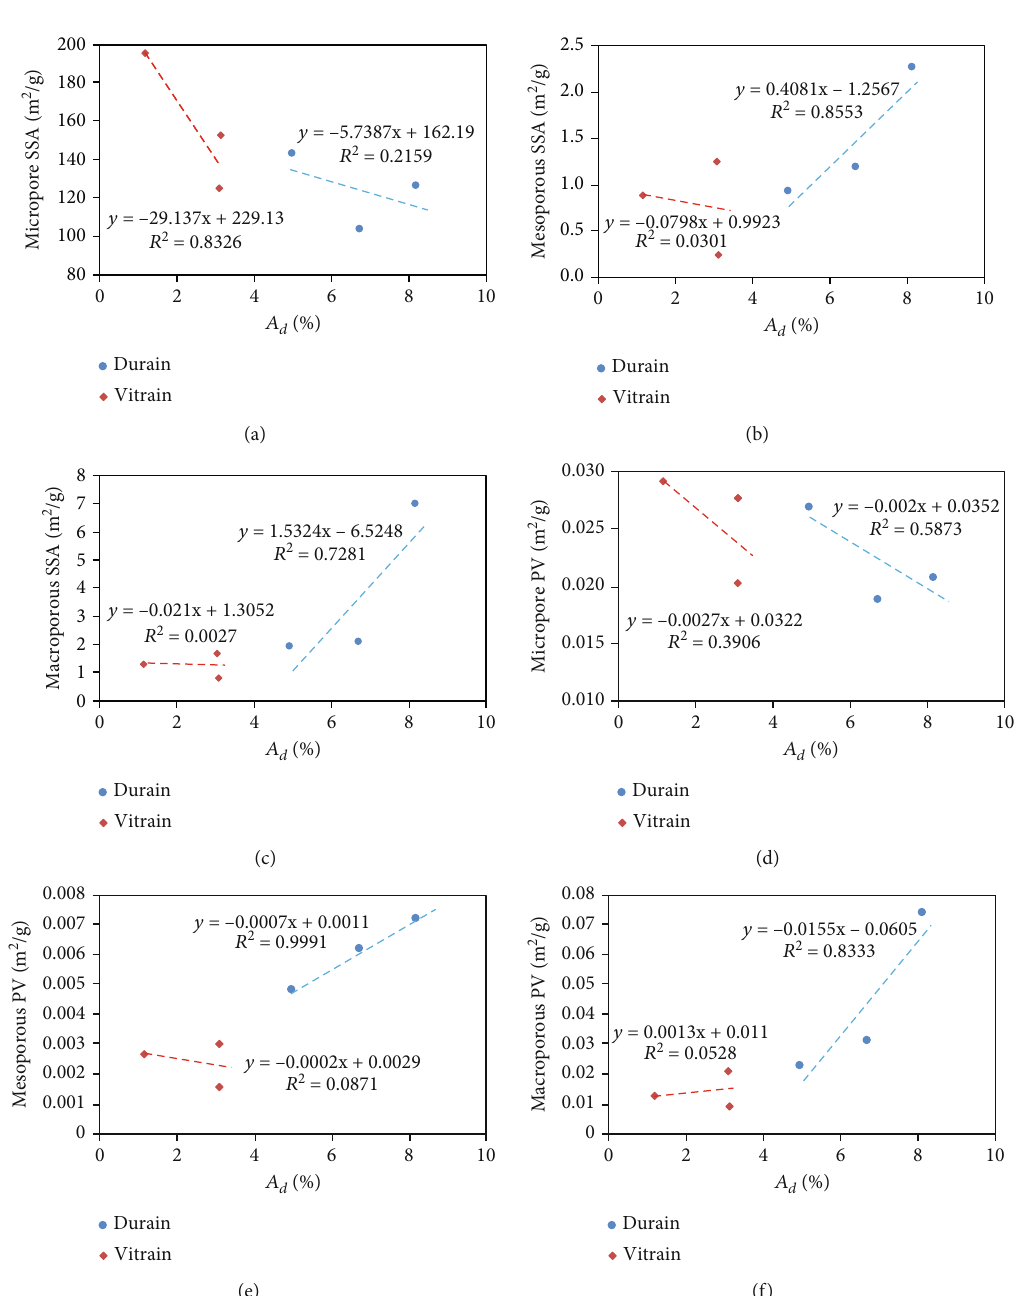
vs. pore width and dV/dlog(D) vs. pore width (Figure 10). According to the curve distribution characteristics in Figure 9, the SSA percentage ranks in the descending